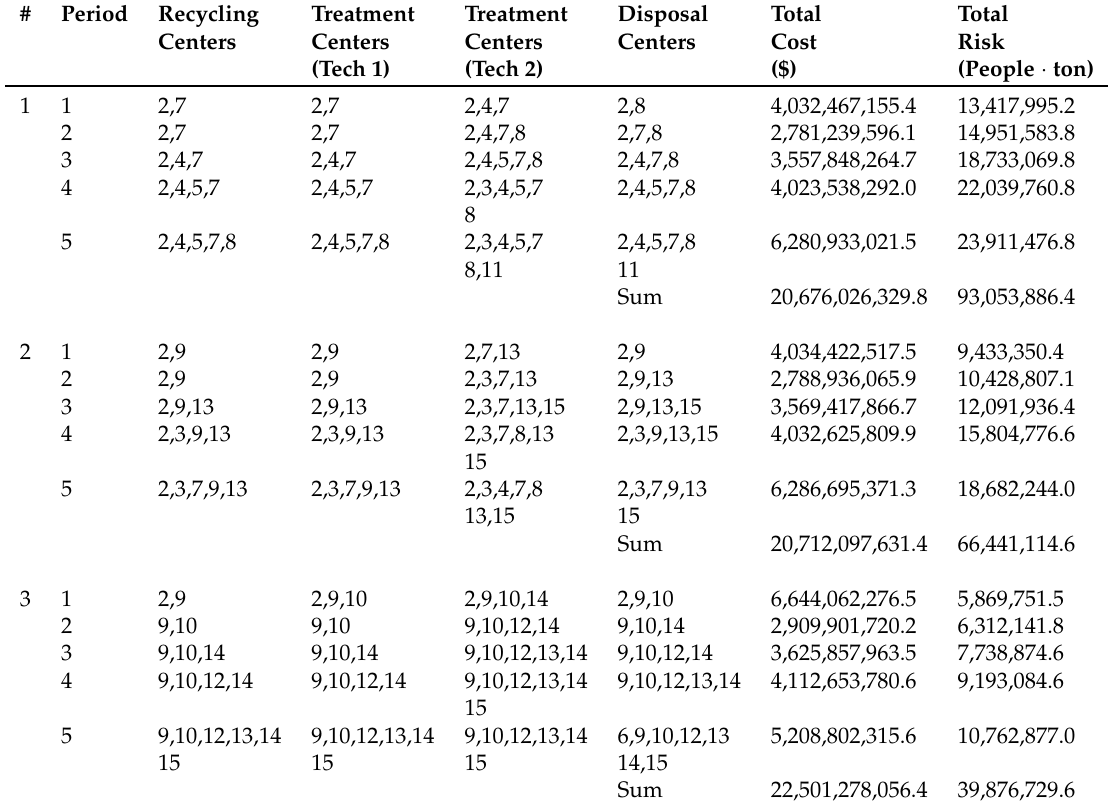
Table 5. Representative non-dominated solutions (multi-period